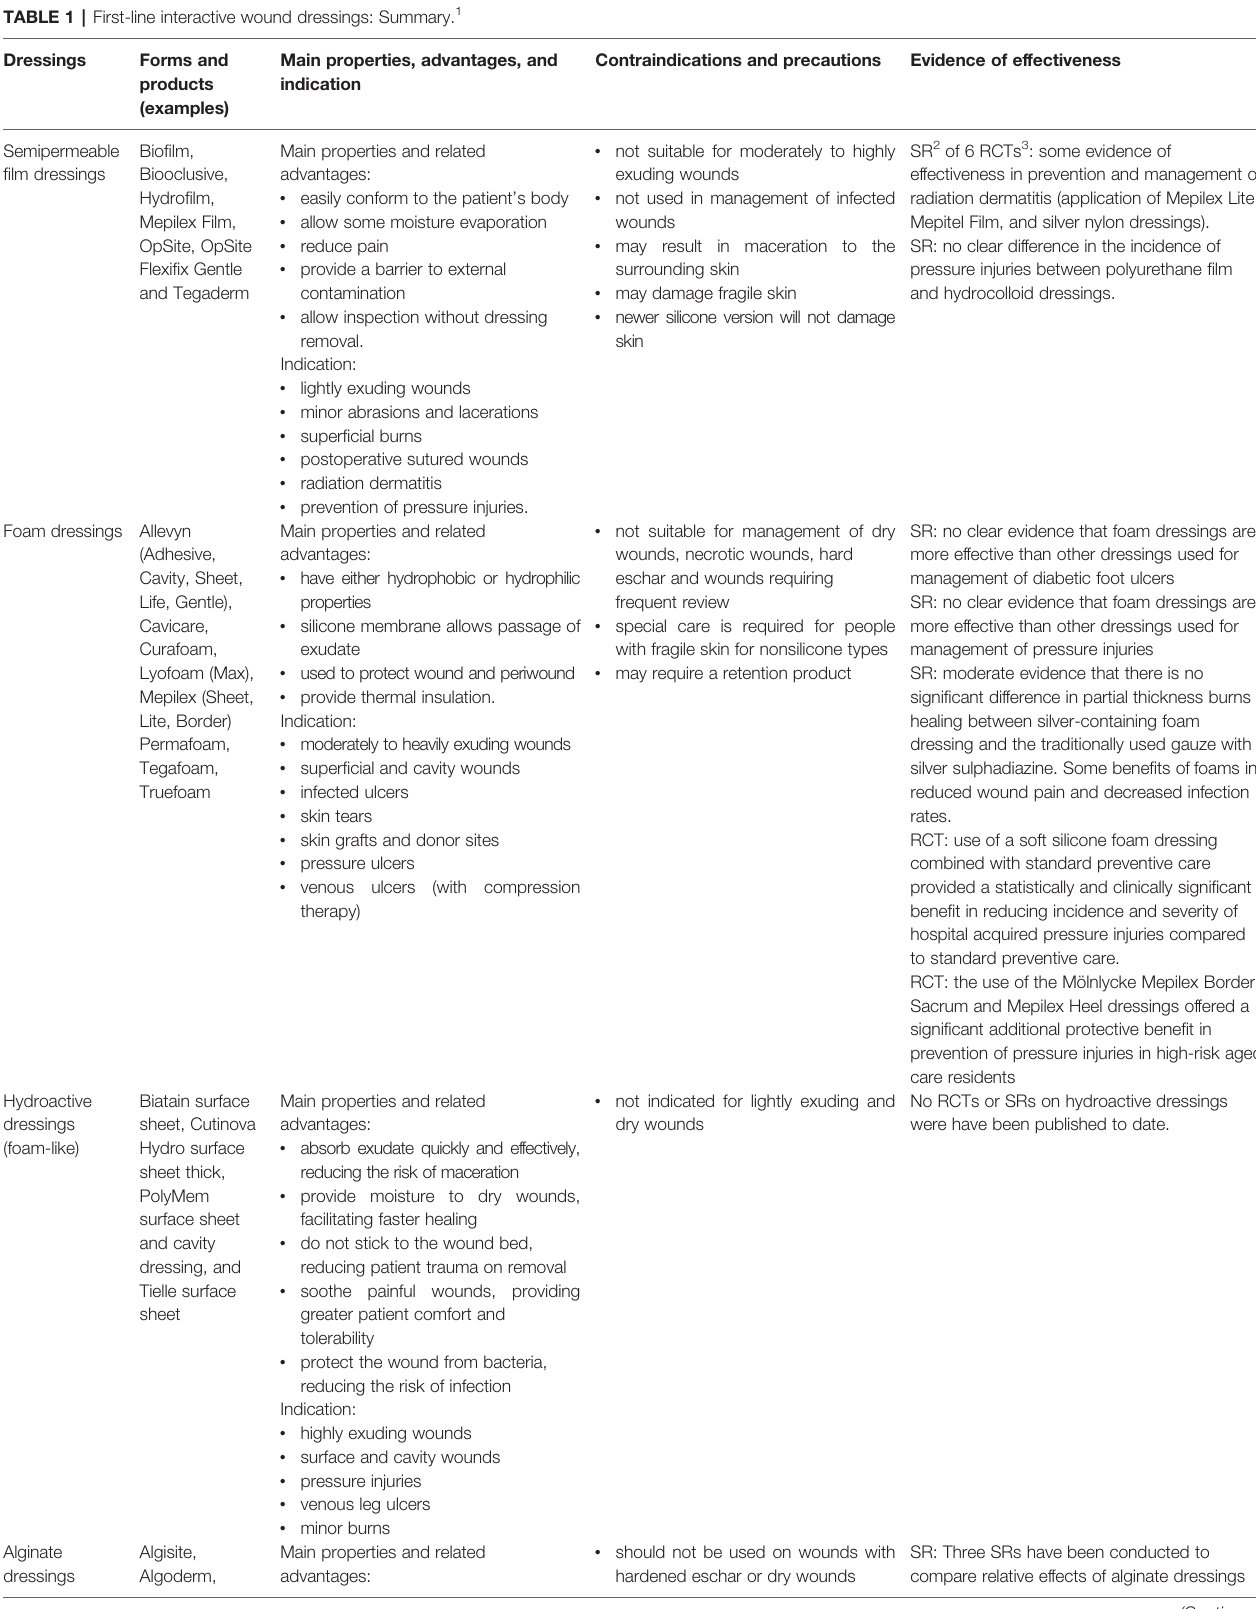
TABLE 1 | First-line interactive wound dressings: Summary. 1